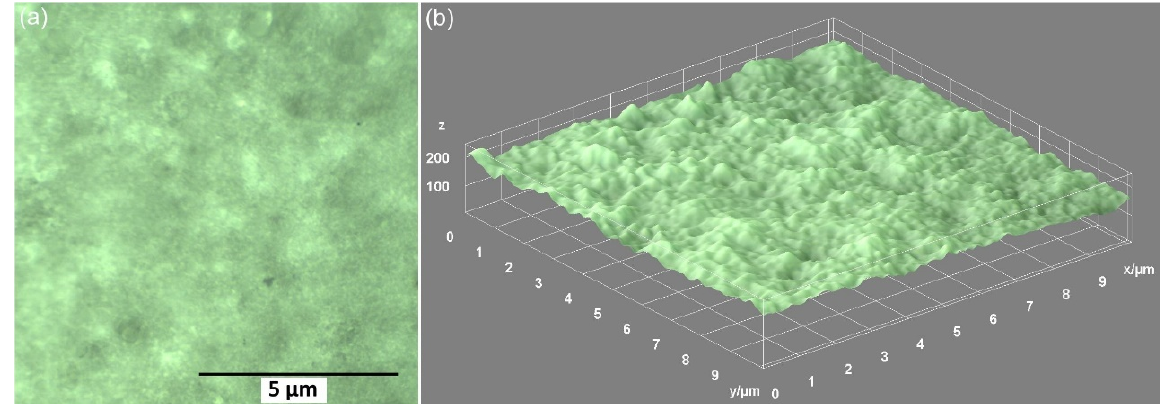
Figure 8. 2D ( a ) and 3D representation ( b ) of optical micrographs obtained on N and Br co-doped HAp thin films (10× magnification).